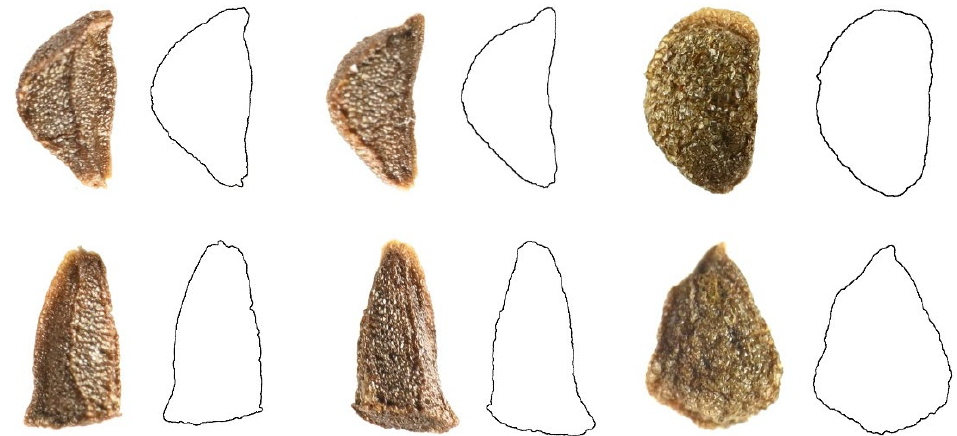
Figure 6. Seed silhouettes with lune-like and polygonal shapes of Peganum harmala L. (Nitrariaceae).